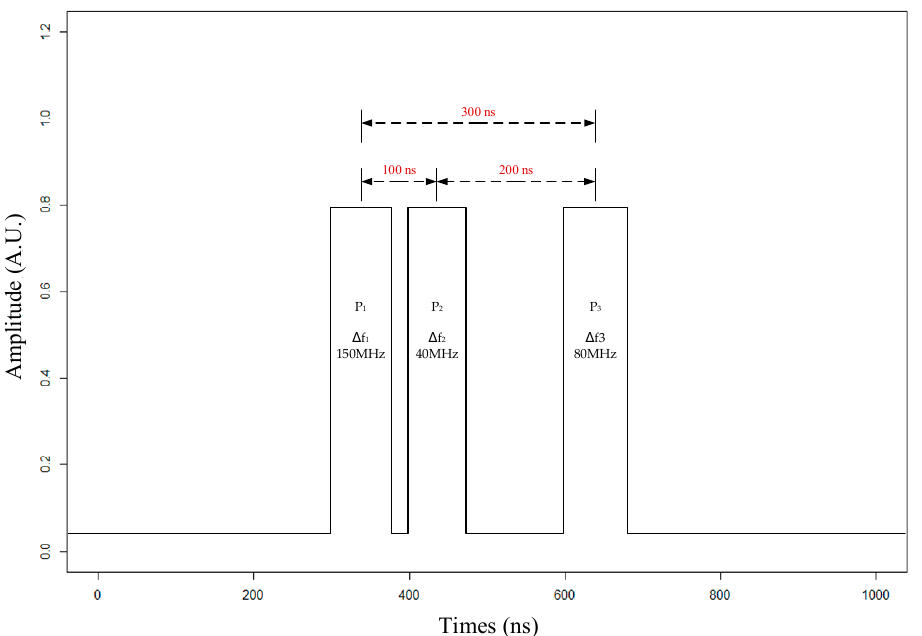
Figure 8. The time domain of three probe Figure 8 The time domain of three probe pulse.